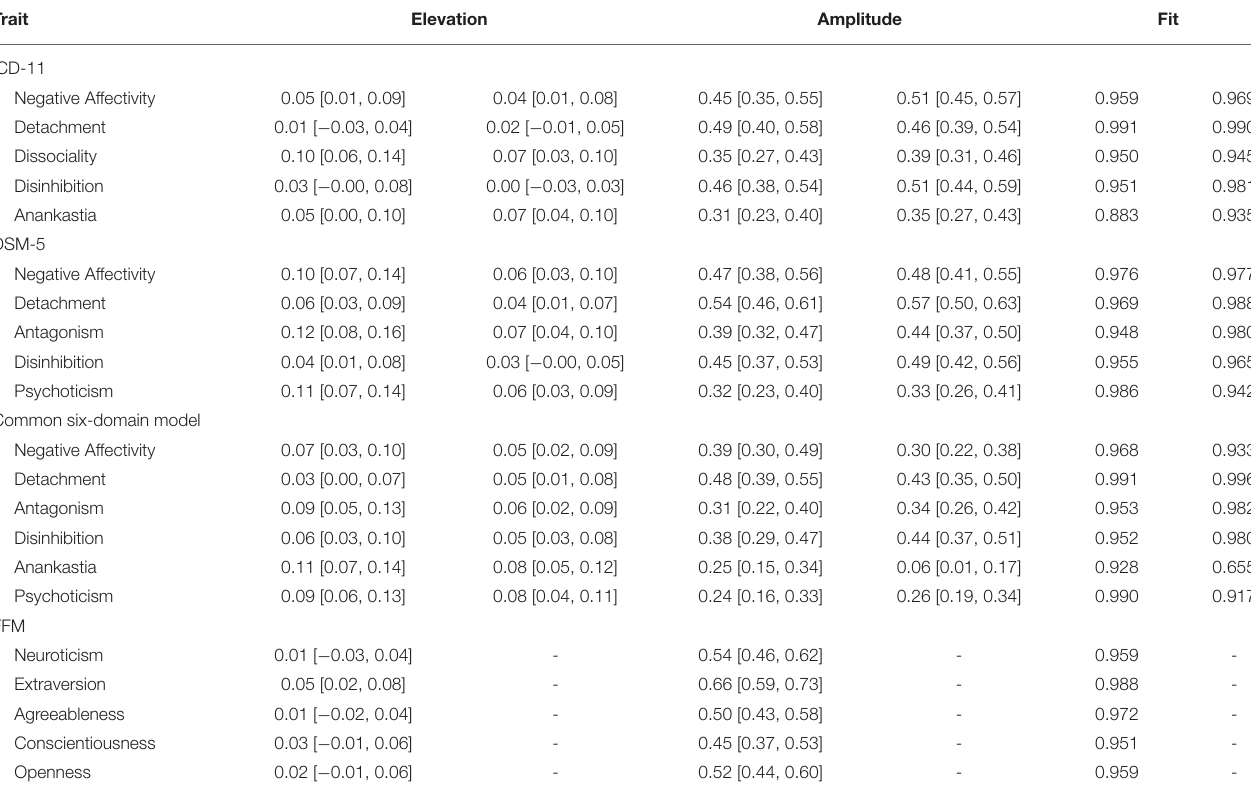
TABLE 3 | Structural summary profiles of the ICD-11, DSM-5, six-domain model, and FFM traits projected on the circumplex space of the CPM for Study 1 (left side) and Study 2 (right side). Trait Elevation Amplitude Fit